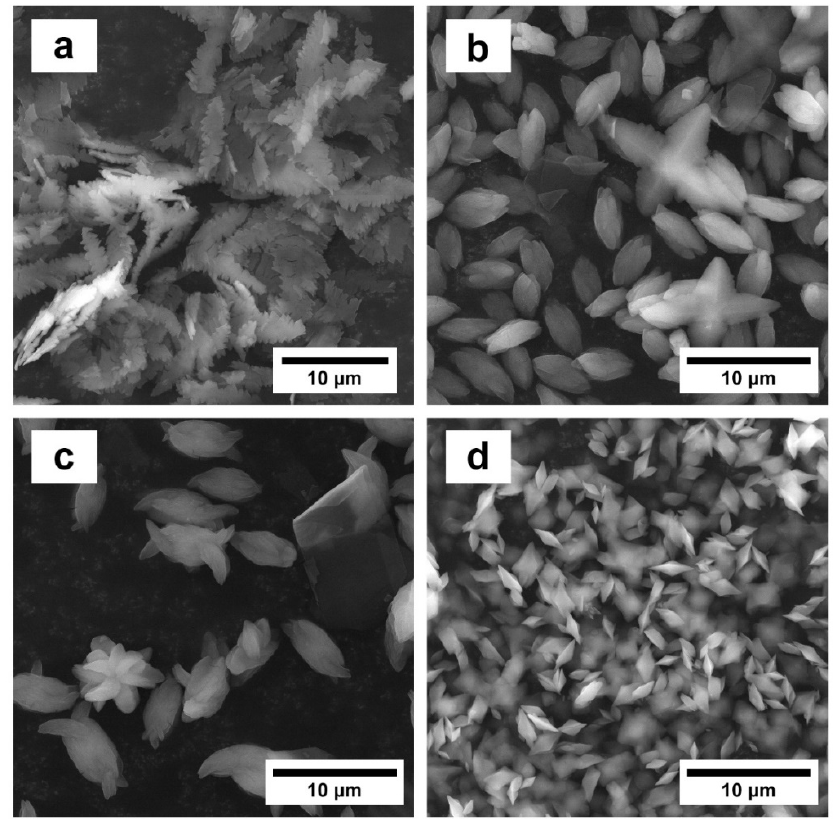
Figure 3 . SEM of various morphological types of calcium oxalate.( a ) Blank, ( b ) Run 17, ( c ) Run 13 and ( d ) Run